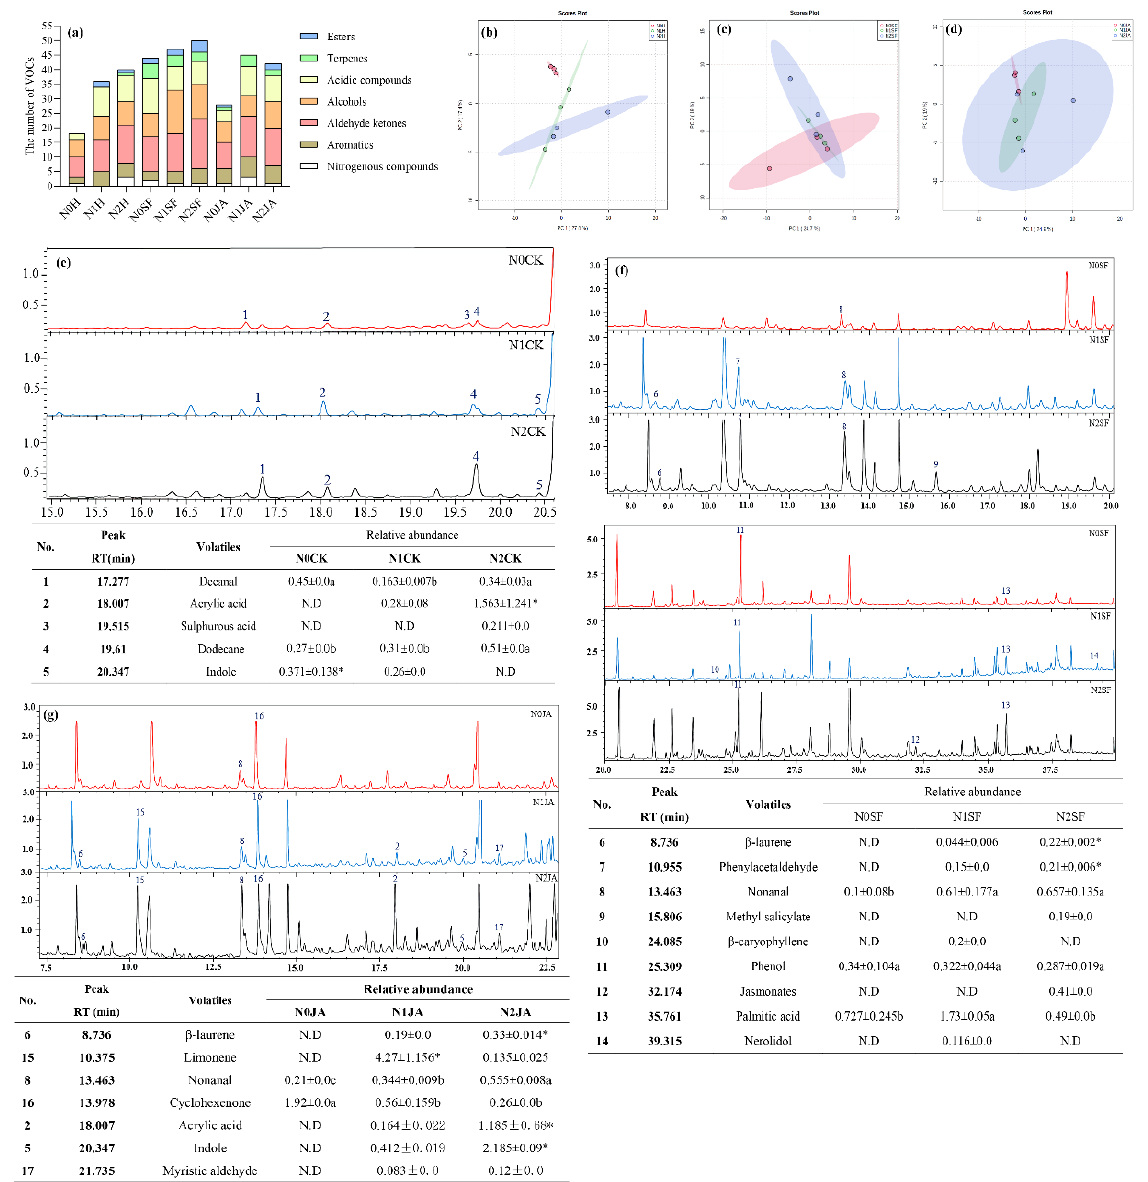
Figure 5. Effects of N supply on volatile organic compounds (VOCs) of maize under different induced treatments. ( a ) The number of volatiles emitted from maize plants from different treatment combinations; ( b – d ) the principal components analysis (PCA) of volatiles emitted from maize plants that were untreated, attacked by S. frugiperda or treated with JA, respectively. ( e – g ) GS-MS chart and the content of the main volatiles emitted by maize plants that were untreated, attacked by S. frugiperda or treated with JA, respectively. RT, retention time. Values followed by the same lowercase letters in the same row were not significantly different among the three N levels. Values followed by the asterisk “*” indicate significant differences between two N levels. “N.D” in the tables indicates not detected.